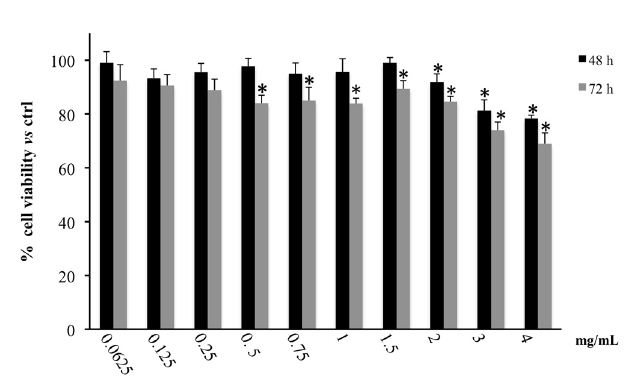
Figure 1. Cell viability in CaCo2 cells treated for 48 and 72 h with the hydroalcoholic extract of M. incana aerial parts evaluated by MTT assay. Values are the mean ± SD of four experiments in triplicate. * Significant vs. untreated control cells: p < 0.001.